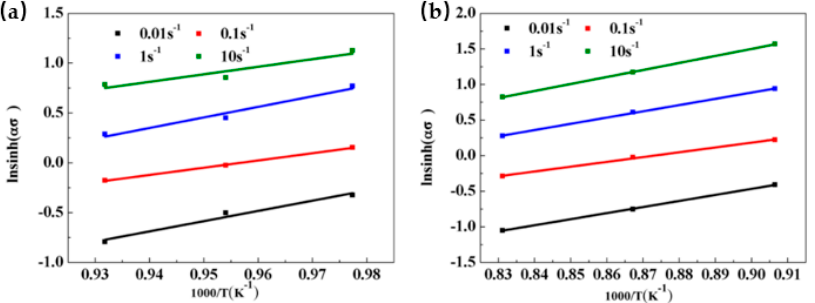
Figure 6. Relationship between lnsinh ( ασ ) and 1000/T at different deformation conditions: ( a ) α + β region; ( b ) β region.